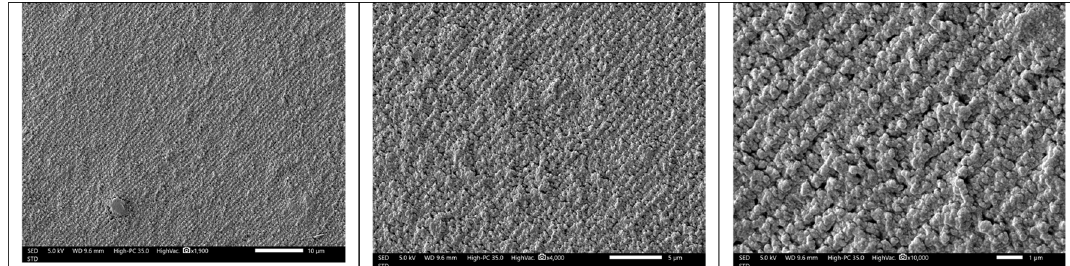
Figure 3. SEM images for a sample of HPDLC with peppermint oil (purity 80%).